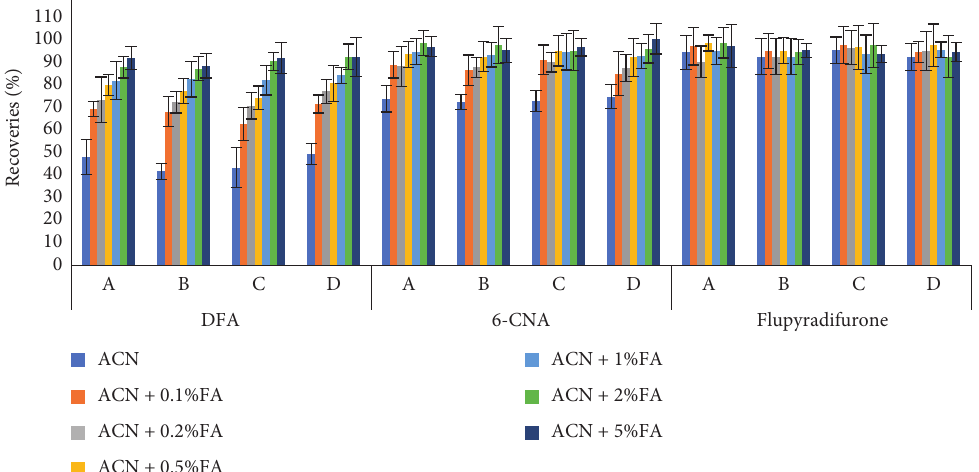
Figure 4: Recovery of flupyradifurone, DFA, and 6-CNA for the method using different concentrations of formic acid ( n �